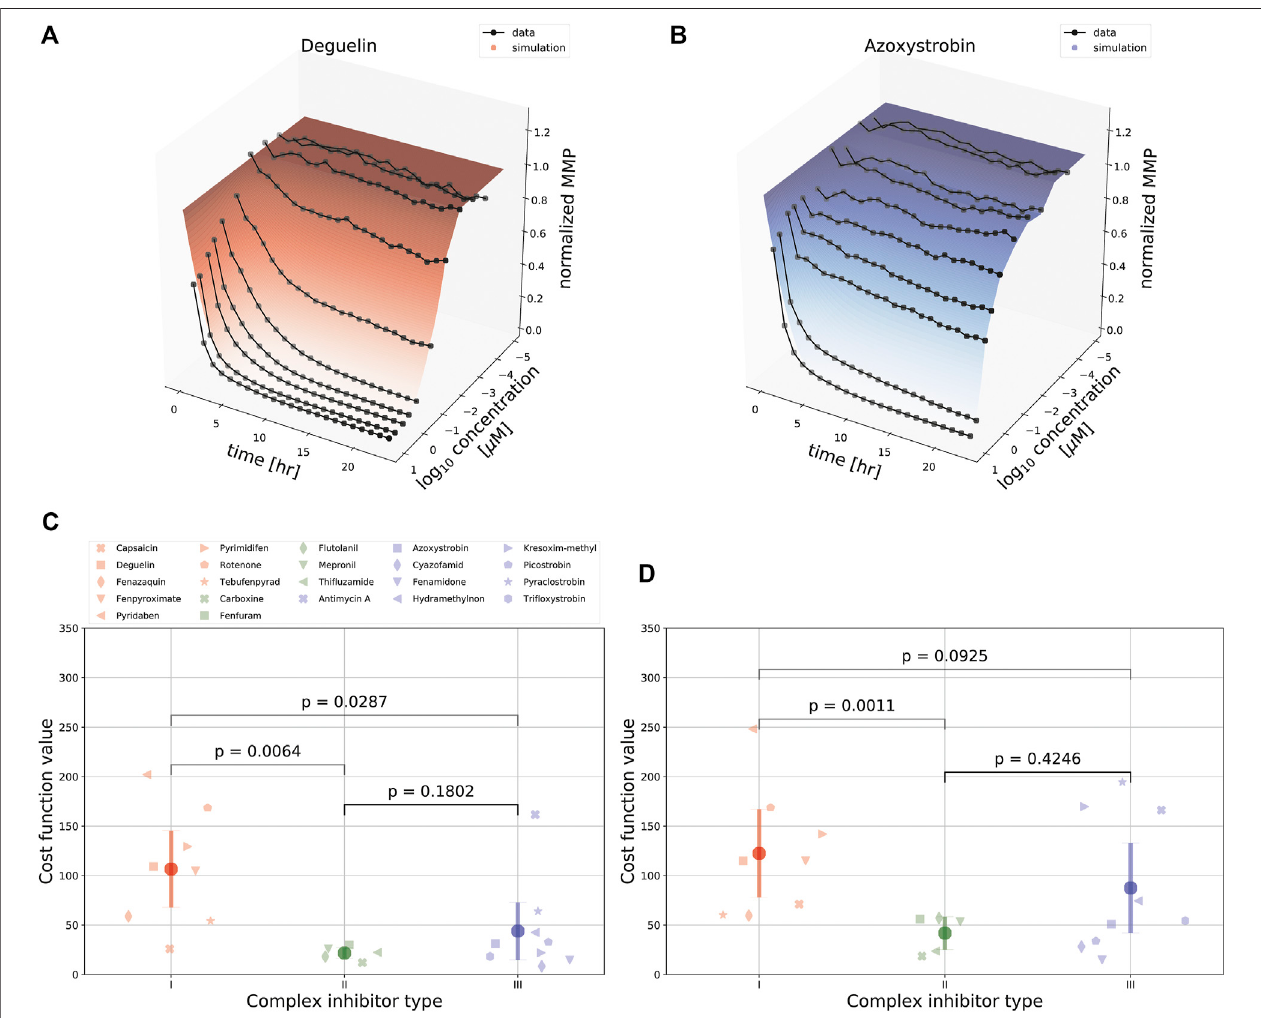
FIGURE 4 | Comparison of model fi ts for various ETC inhibitors. (A, B) Landscape of simulated (shaded curved planes) and experimentally determined (gray lines and symbols) concentration-time MMP response followingexposureofHepG2 cellsto deguelin (A) or azoxystrobin (B) . Note thatin these model fi tsseveral parameters were required to be the same across all 22 ETC inhibitors used in the experiments (see Section 2 ). (C, D) Model fi tting performance for all 22 ETC inhibitors (symbols) tacklingcomplexI(red), II(green),orIII (blue), [either fi ttingthedataforeach inhibitor separatelywithallmodel parameters kept free (C) ,orusingthecombineddata for fi tting with particular parameters in common (D) . The p -values in (C, D) are based on a KS test.